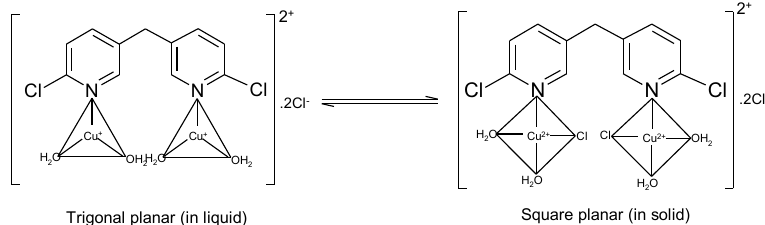
Figure 3. Inter conversion of Cu(I) and Cu(II).